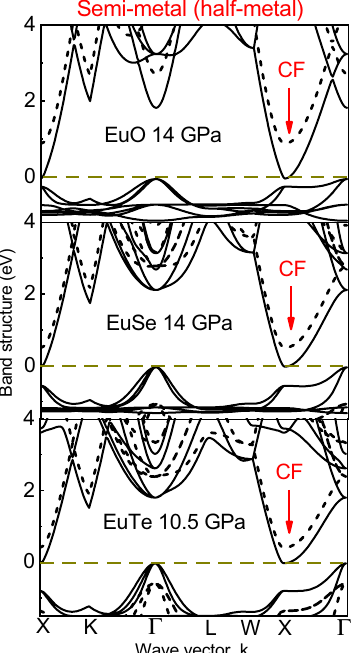
Figure 6. Band structure of EuO (up), EuSe (middle) and EuTe (down) at 14 GPa and 10.5 GPa, respectively, at the semiconductor to half-metal